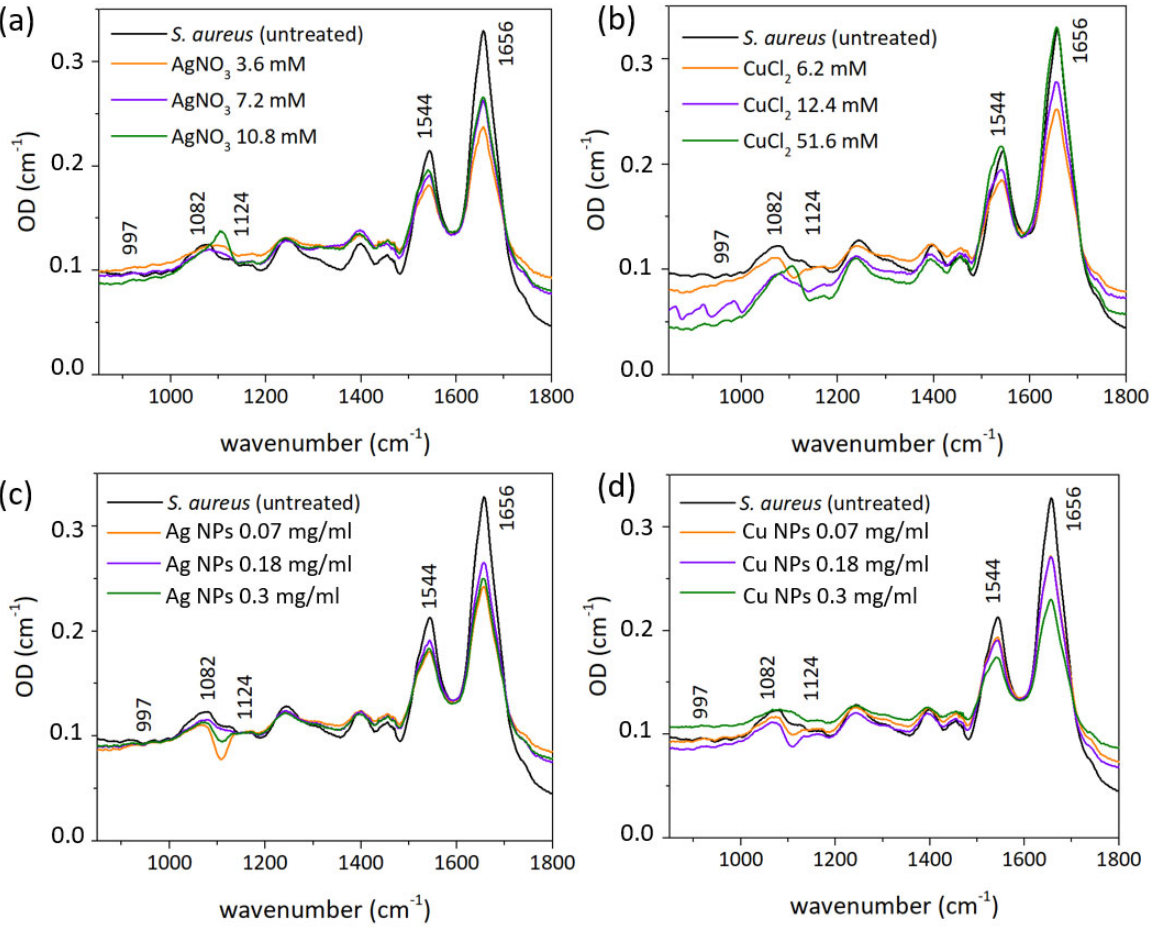
Figure 8. Selected regions (850–1800 cm − 1 ) of FT − IR spectra of S. aureus before and after treatment with ( a ) AgNO 3 , ( b ) CuCl 2 , ( c ) Ag NPs, and ( d ) Cu NPs solutions with different concentrations.